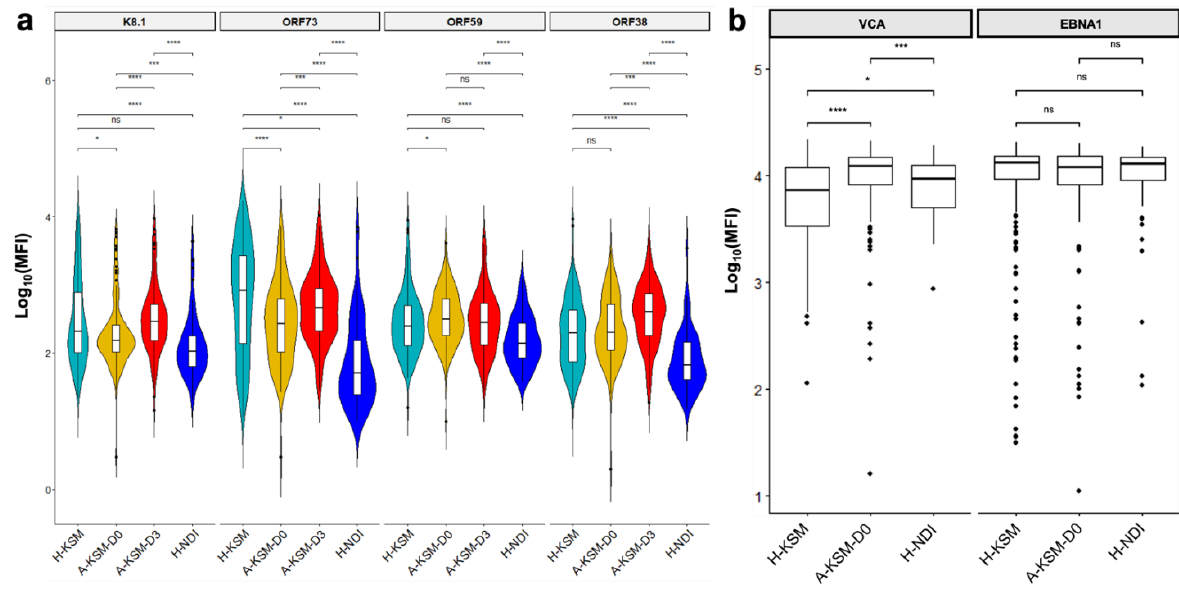
Figure 2. Increased IgG antibodies against KSHV lytic antigens during acute malaria episodes ( a ) Log-scale comparison of KSHV IgG antibodies against early (ORF59), late (K8.1) lytic, latency-associated (ORF73) antigens, and structural tegument protein ORF38 in A-KSM-D0 (cyan), H-KSM-D0 (yellow), H-KSM-D3 (red) and H-NDI (blue) (* p < 0.05; *** p < 0.001; **** p < 0.0001, ns: p > 0.05) ( b ) Log-scale comparison of EBV IgG antibodies against VCA during acute malaria infection. Significant differences are based on the Wilcoxon rank-sum test with Benjamini–Hochberg (BH) correction for multiple comparisons where appropriate (* p < 0.05; *** p < 0.001; **** p < 0.0001, ns: p > 0.05). Boxplots include the sample medians, minimum/maximum values and first/third quartiles. Abbre-